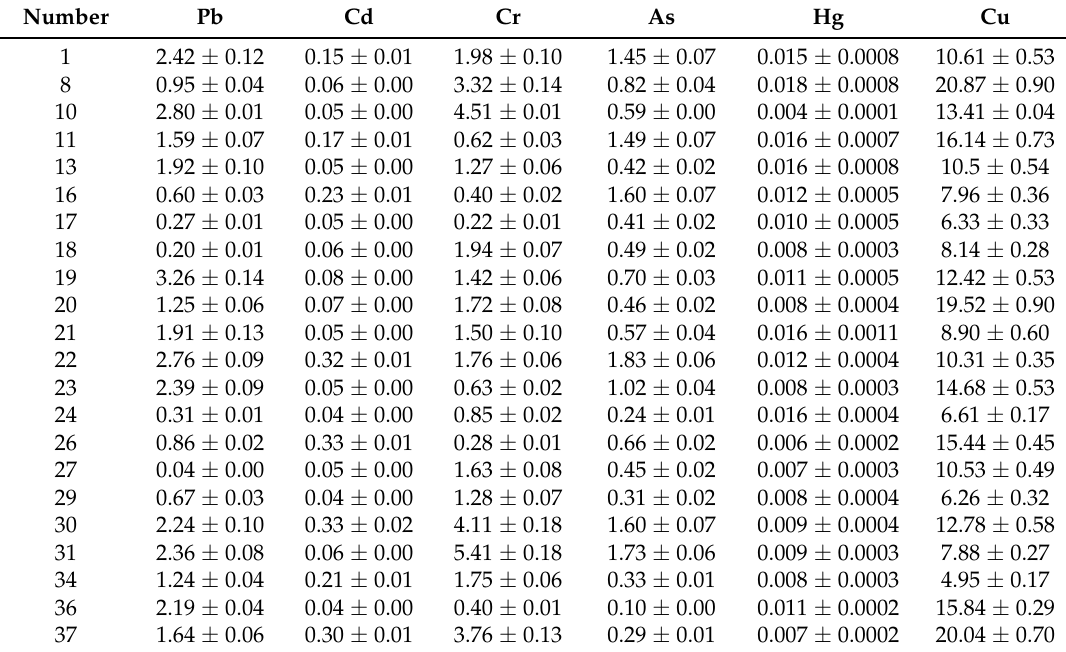
Table 9. Heavy metals contents in rhizome of P. notoginseng (mean ± SD, mg · kg − 1 ).